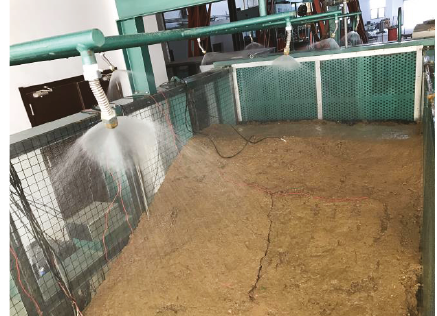
Figure 10: Rainfall and fl ooding